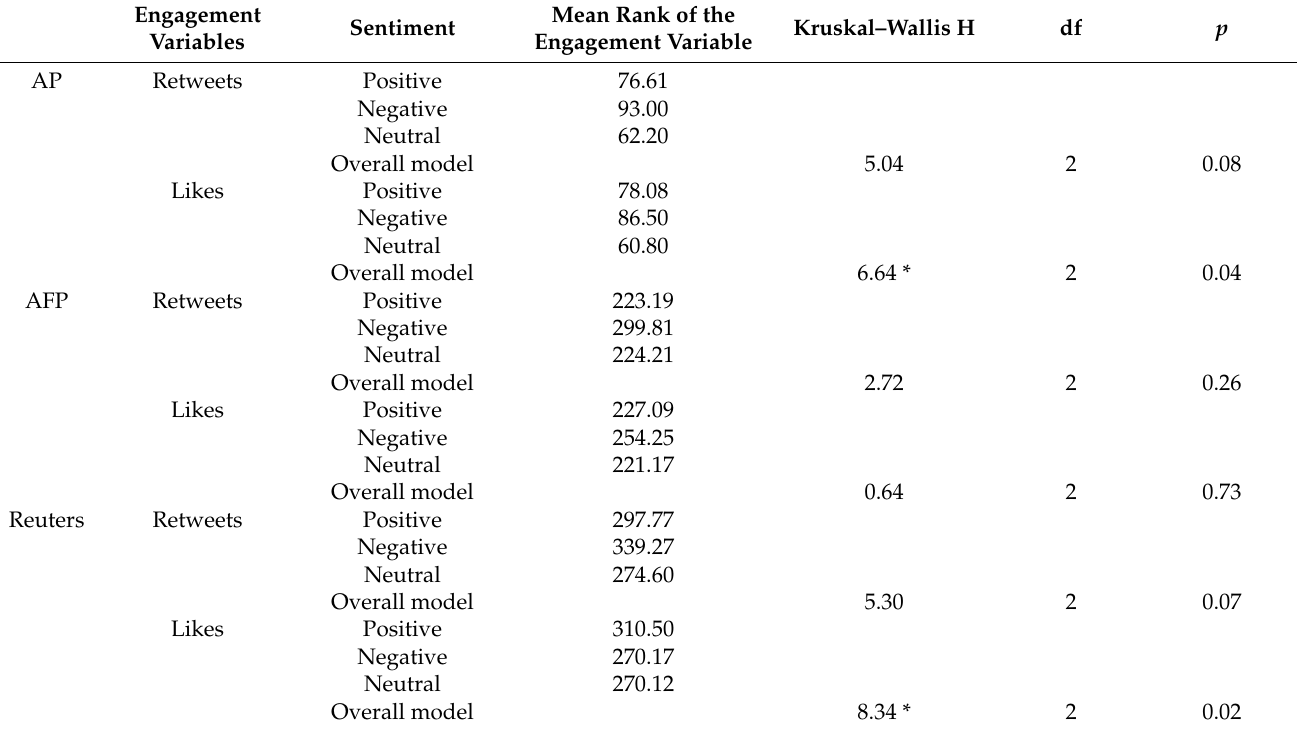
Table 8. Tweets’ sentiments regarding COVID-19 vaccines and Twitter engagement by news